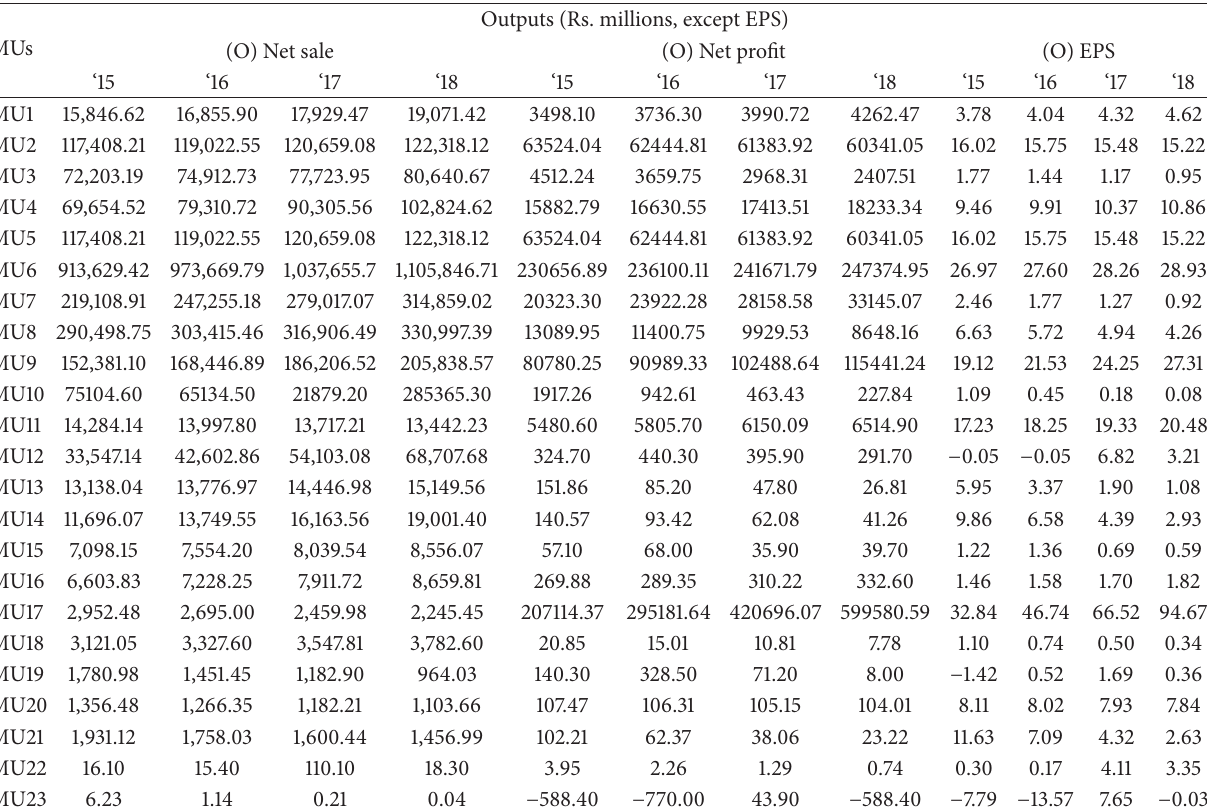
Table 3: Forecasted values of outputs of all DMUs from 2015 to